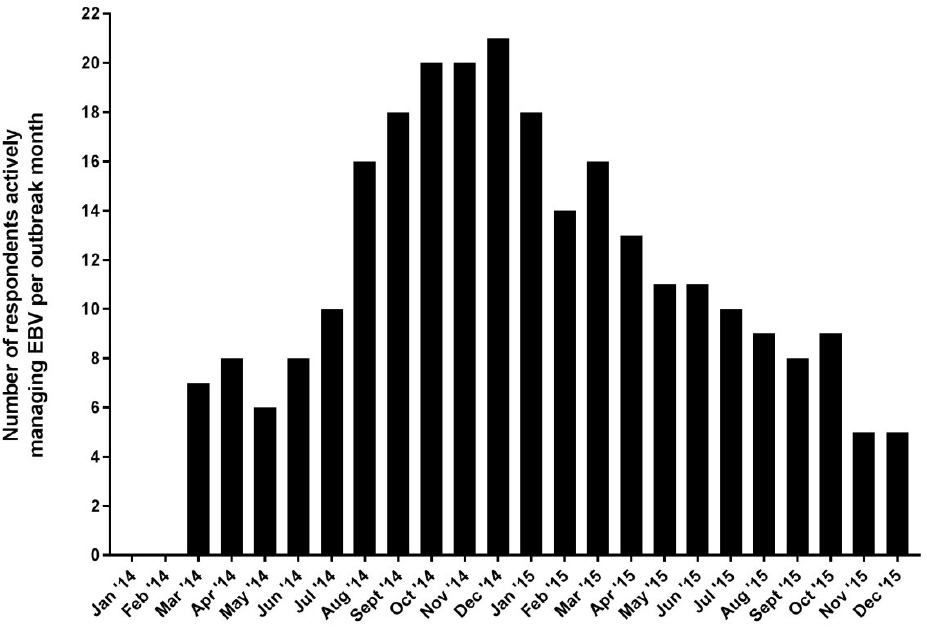
Figure 2. Number of active respondents by outbreak period.